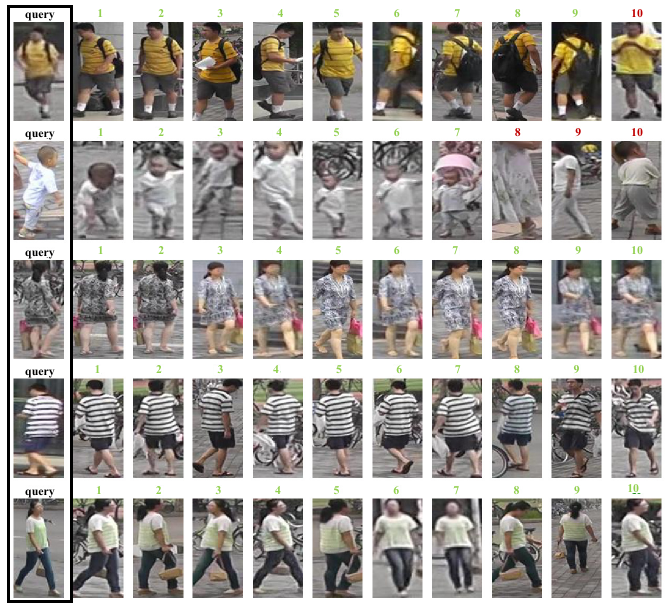
Figure 7. Pedestrian retrieval results on the Market-1501 dataset. The first column in the black box shows five different identity query images. The other columns show the results sorted according to the similarity in which the sort orders are marked by serial numbers. The green numbers represent the retrieved images that are the same identities as the query, and the red numbers represent those without the same